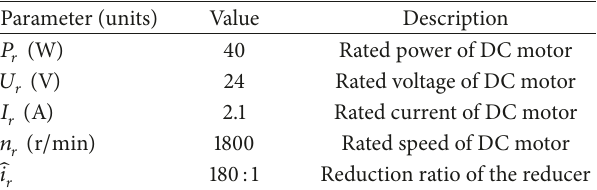
Table 1: Parameters of the DC gear